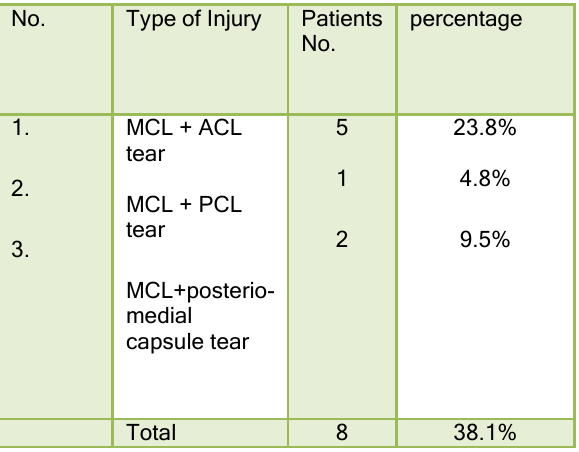
Table (2): Associated Injuries of MCL Tear